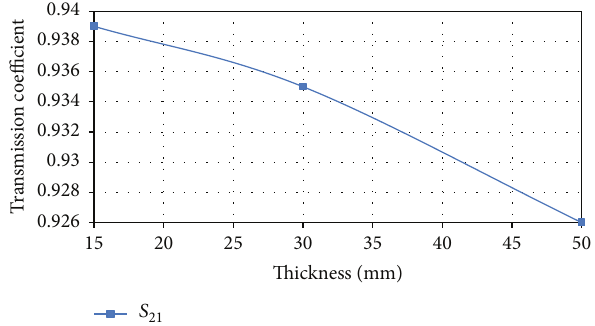
Figure 2: Transmission coefficient versus material thickness (PTFE).